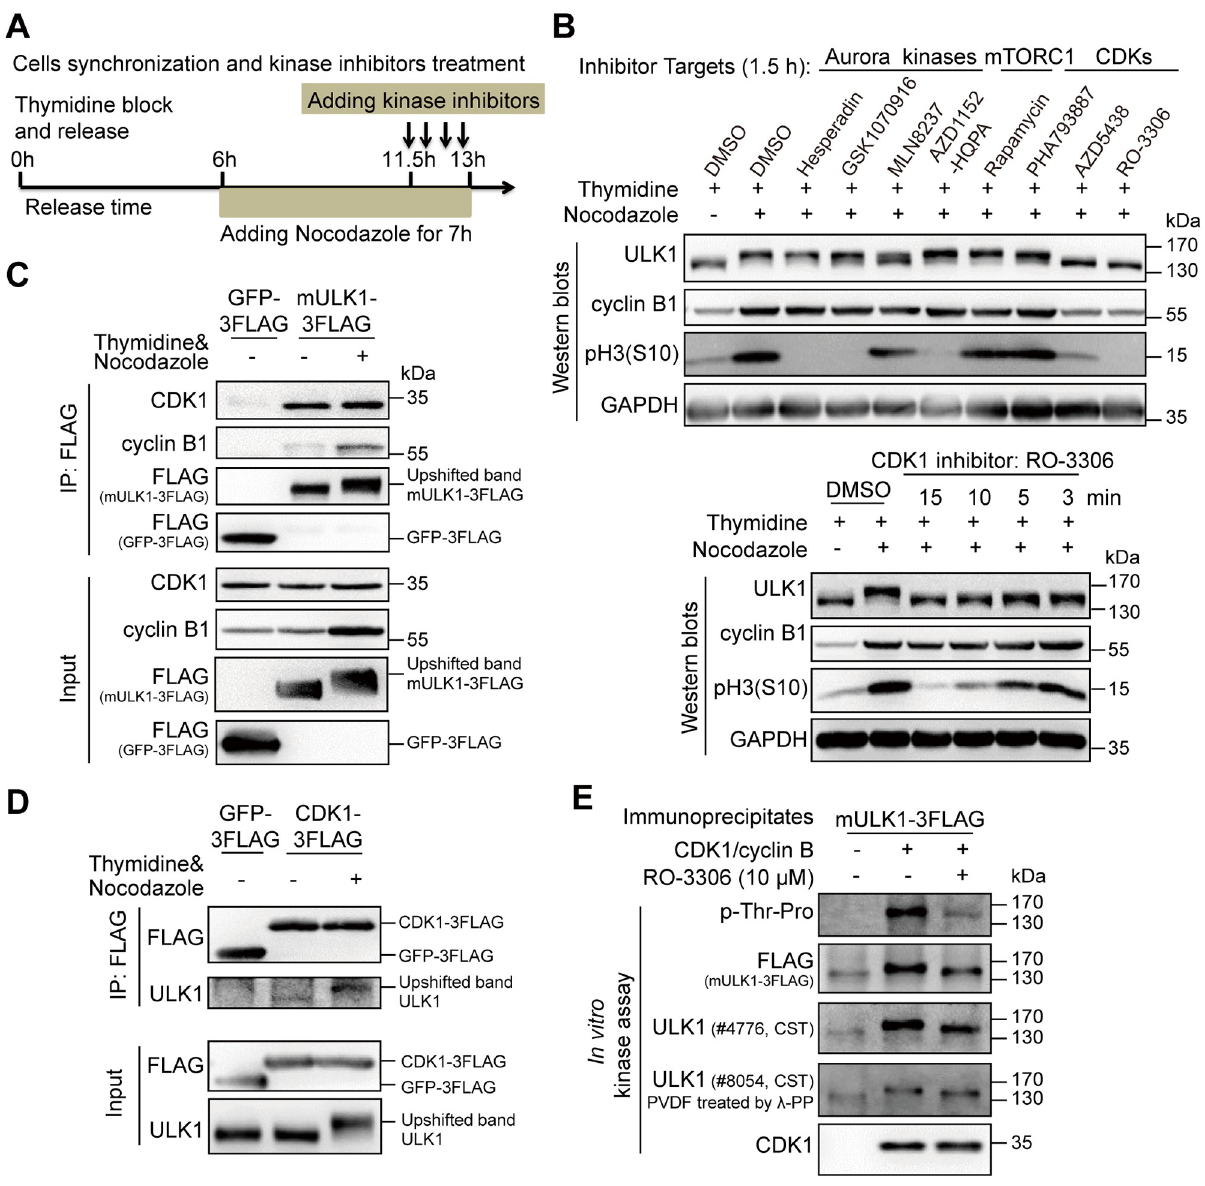
Fig 3. ULK1 is a substrate of CDK1/cyclin B in mitosis. (A) Illustration of cell synchronization and kinase inhibitors treatment. HeLa cells were synchronized with single-thymidine and nocodazole. Kinase inhibitors were added for different timepoints, ranging from 3 minutes to 1.5 hours. (B) CDK1 inhibitors, but not Aurora kinase, mTORC1, and other CDK inhibitors, abolished the ULK1 band shift in mitosis. HeLa cells synchronized and treated as (A) were subjected to western blot analysis. (C-D) ULK1 coimmunoprecipitates with CDK1 and vice versa. 293T cells stably overexpressing FLAG-tagged mULK1 or CDK1 were synchronized with single-thymidine and nocodazole and the coimmunoprecipitates were subjected to western blot analysis. (E) ULK1 is upshifted and phosphorylated by purified CDK1/cyclin B complex in vitro. Purified CDK1/cyclin B complex as kinase and the ULK1 immunoprecipitates from asynchronous 293T cells overexpressing FLAG-tagged mULK1 as substrate with or without RO-3306 were subjected to in vitro kinase assay and western blot analysis. CDK, cyclin-dependent kinases; CST, Cell Signaling Technology; GAPDH, glyceraldehyde 3-phosphate dehydrogenase; GFP, green fluorescent protein; IP, immunoprecipitation; mTORC1, mammalian target-of-rapamycin complex 1; mULK1, mouse ULK1; PVDF, polyvinylidene fluoride; ULK1, unc-51-like autophagy activating kinase 1; λ -PP, lambda phosphatase.